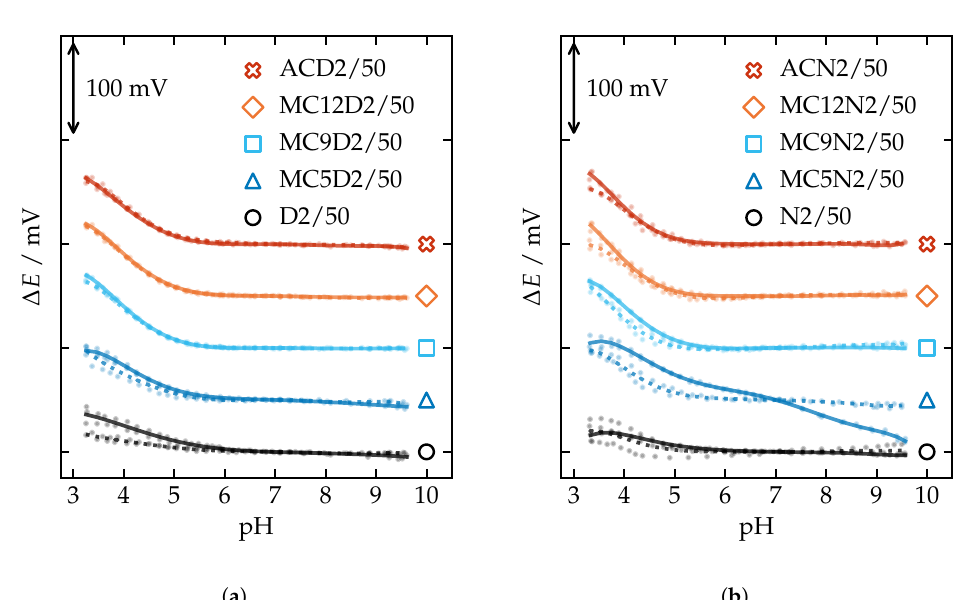
Figure A6. pH sensitivity of sensors with membranes containing 2wt.% ionophore, 50mol.% (relative to the ionophore) TDMACl, and either ( a ) DOS or ( b ) o -NPOE as the plasticizer. Polynomials ( n = 7) fitted to the results of PVC- and PCTFE-shelled sensors are shown as solid and dotted lines, respectively. Measurements were performed in 10 − 2 M acetic acid titrated with a mixture of 0.25M NaOH and 10 − 2 M sodium acetate. See Table 1 for membrane compositions.